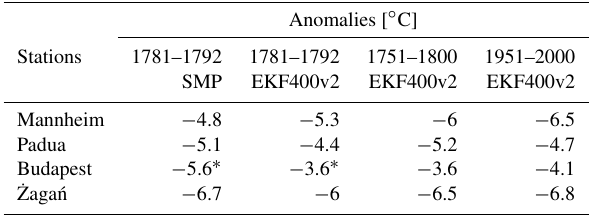
Table 4. Monthly anomalies for March 1785 at four stations in cen- tral Europe: Mannheim, Padua, Budapest, and ˙Zaga´n. The first col- umn is calculated with respect to monthly climatologies from the SMP instrumental measurements, whereas the other three columns are calculated with respect to the climatologies of the EKF400v2 reanalysis grid boxes closest to the location of the four stations.